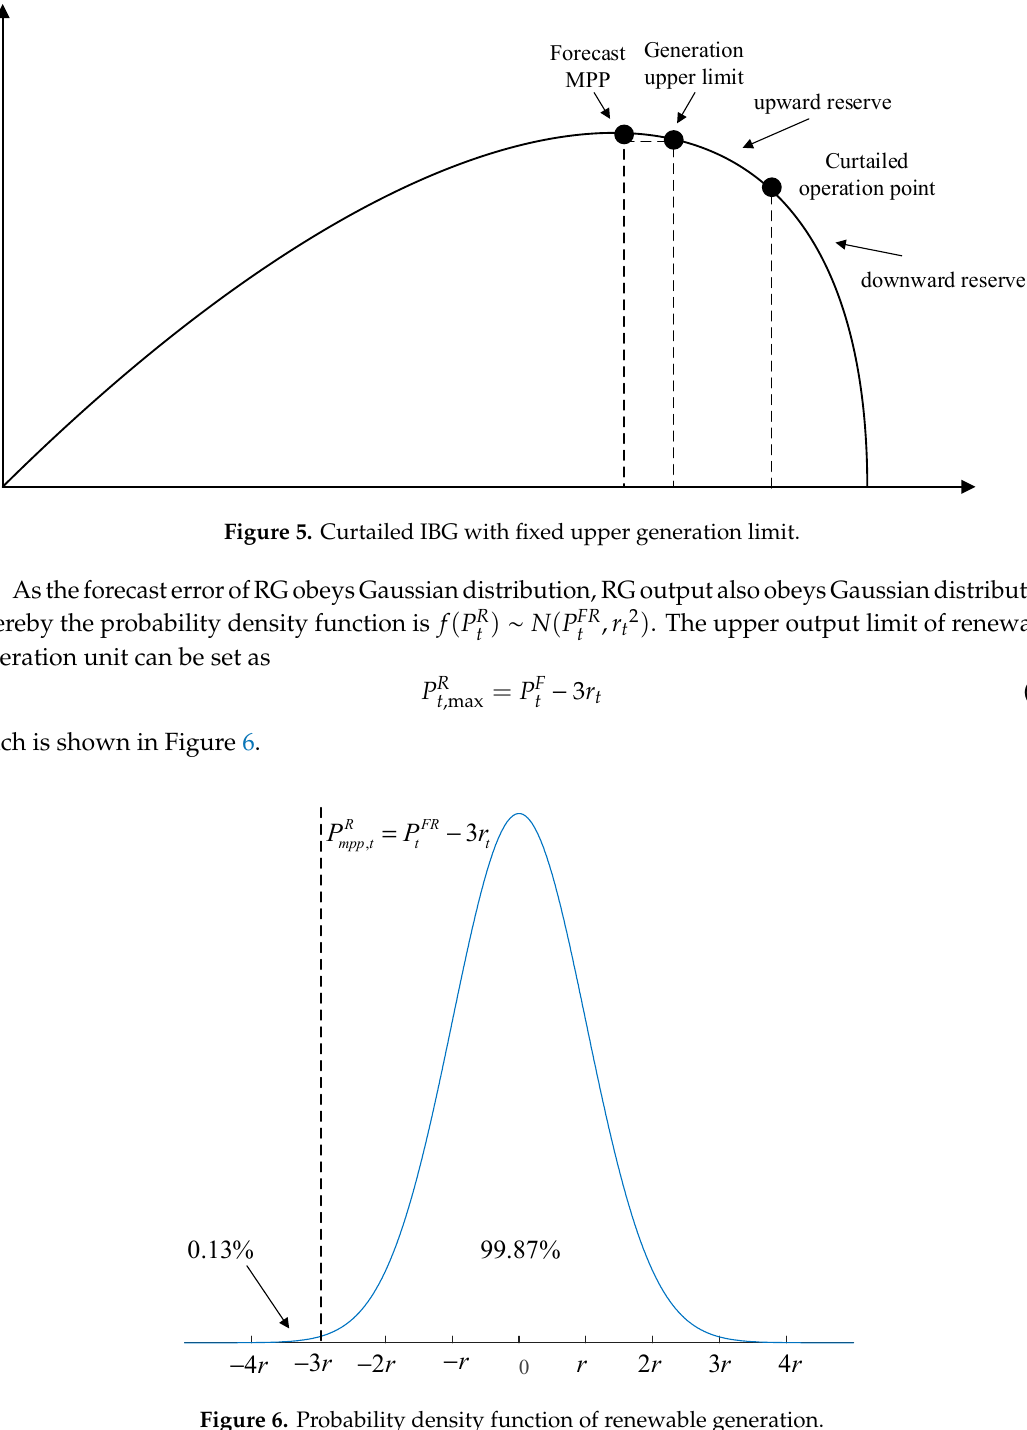
Figure 6. Probability density function of renewable generation.